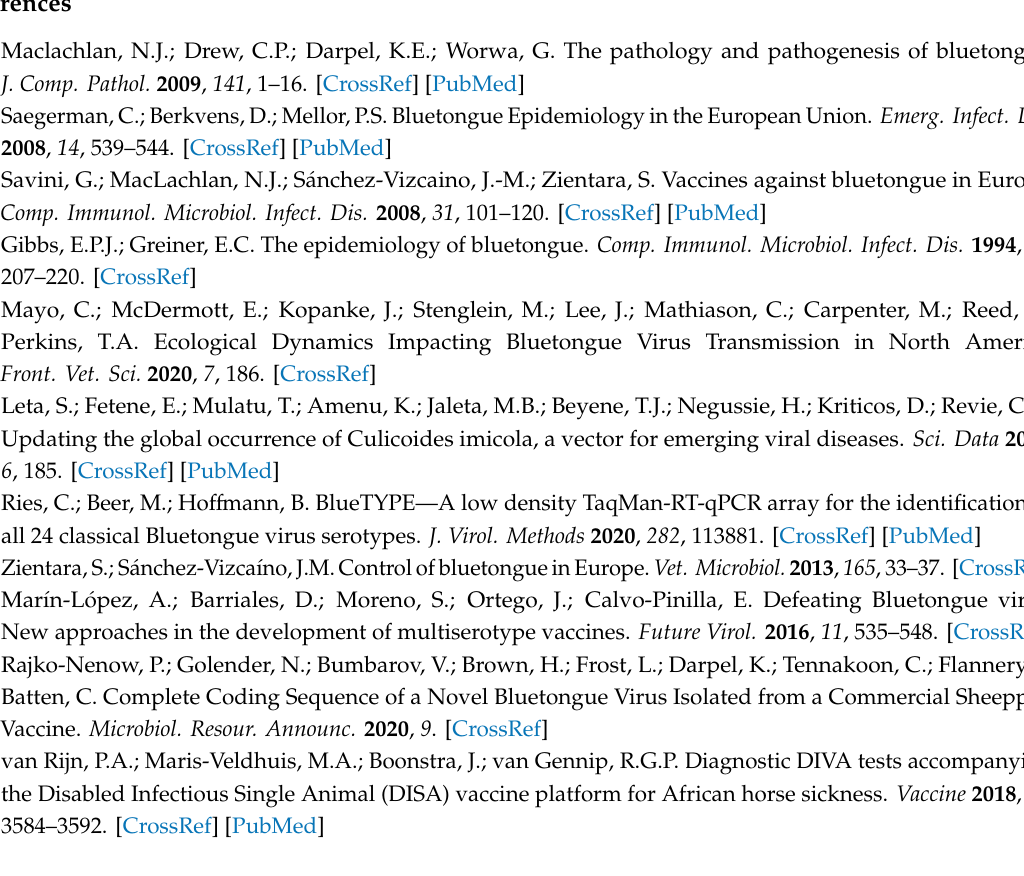
Figure S1: Immunization schedules and groups of mouse studies, Figure S2: Immunization schedule and groups of sheep studies, Figure S3: Humoral responses against BTV-4M elicited by MVA and ChAdOx1 in IFNAR(- / -)